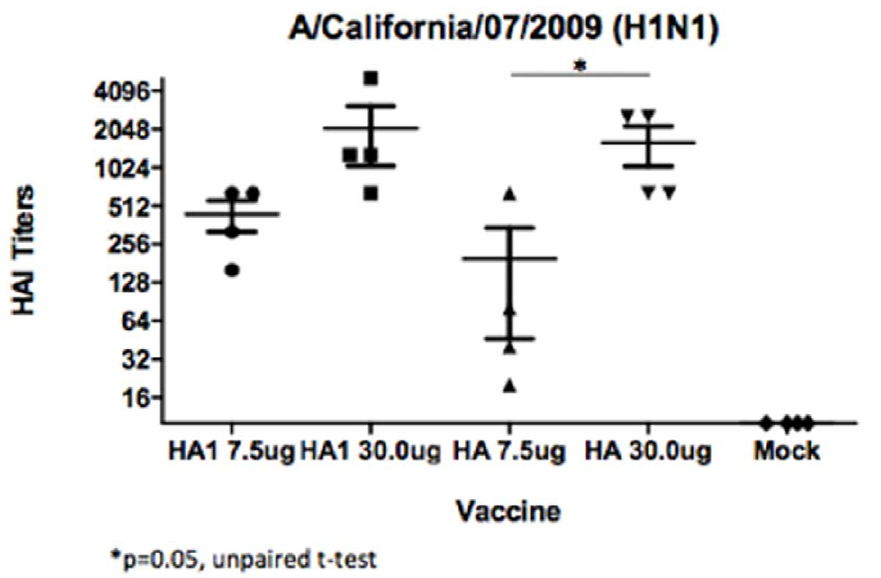
Figure 3. Hemagglutination-inhibition (HAI) titers in ferrets. HAI antibody in ferrets ( n =4 per group) vaccinated with either 30 m g or 7.5 m g of influenza H1N1 HA1 or HA. Blood was collected at day 35 (post-dose 2). HAI responses were assessed against A/California/07/2009. Bars indicate geometric mean titer (GMT). The titer from each individual ferret is indicated by symbol. * p =0.05 HA (1–480) low dose vs. HA (1–480) high dose.